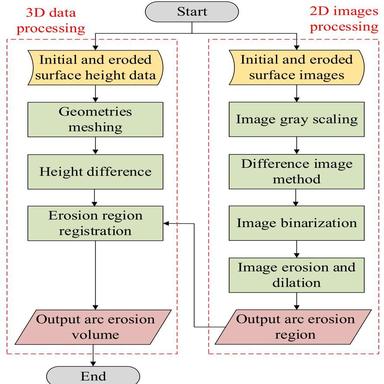
Flowchart of arc erosion volume measurement.